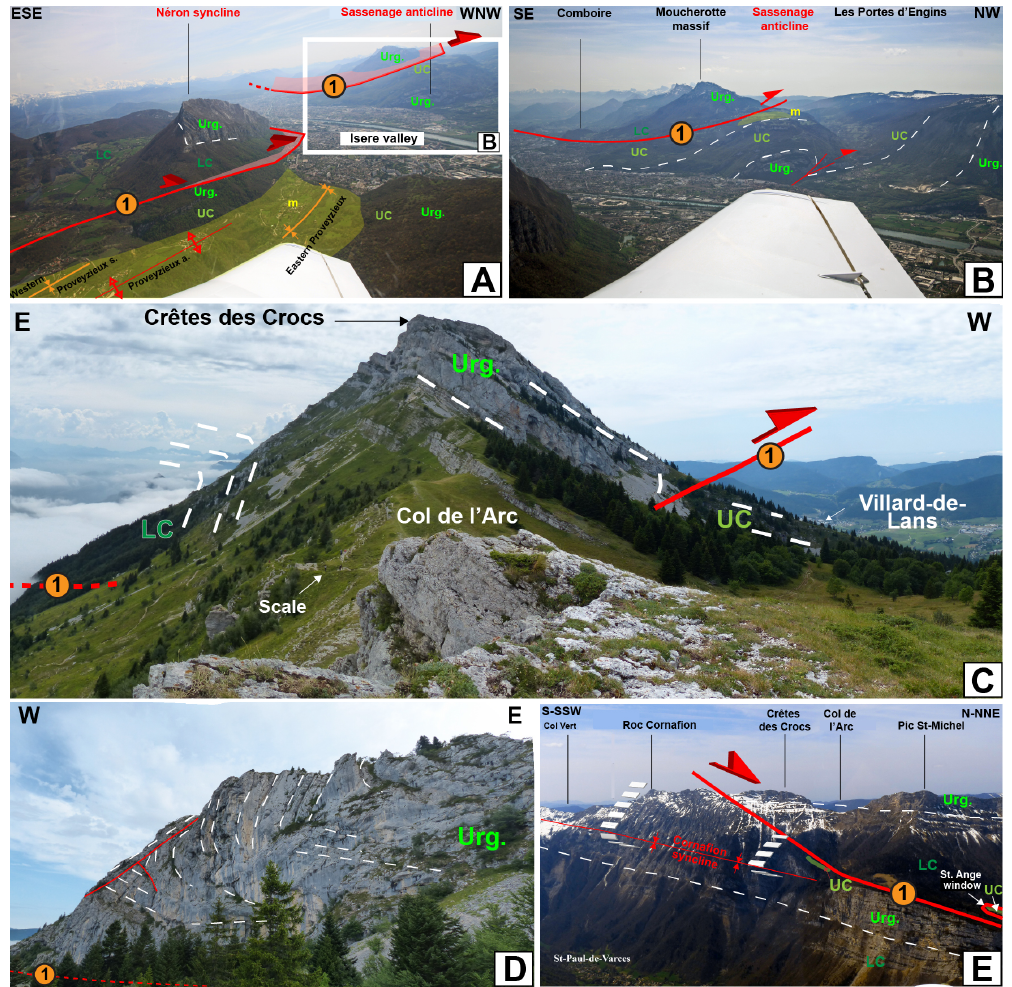
tion (Fig. 7F) and 3.3 km along the Pic St. Michel